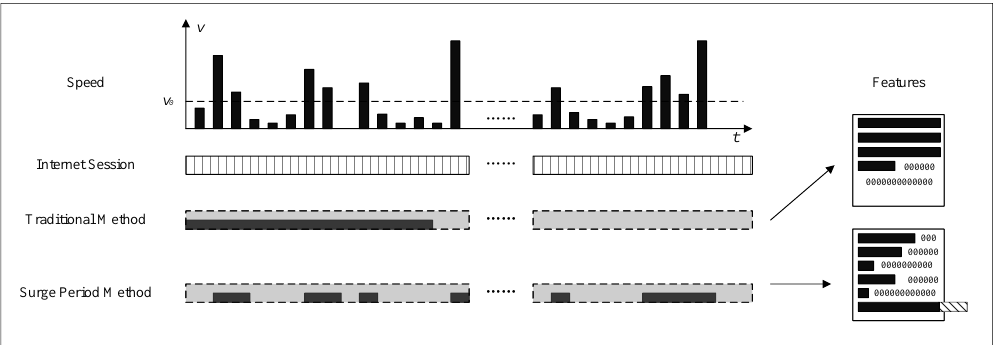
Figure 2. The flow diagram of the surge period-based feature extraction method and the traditional one without surge period